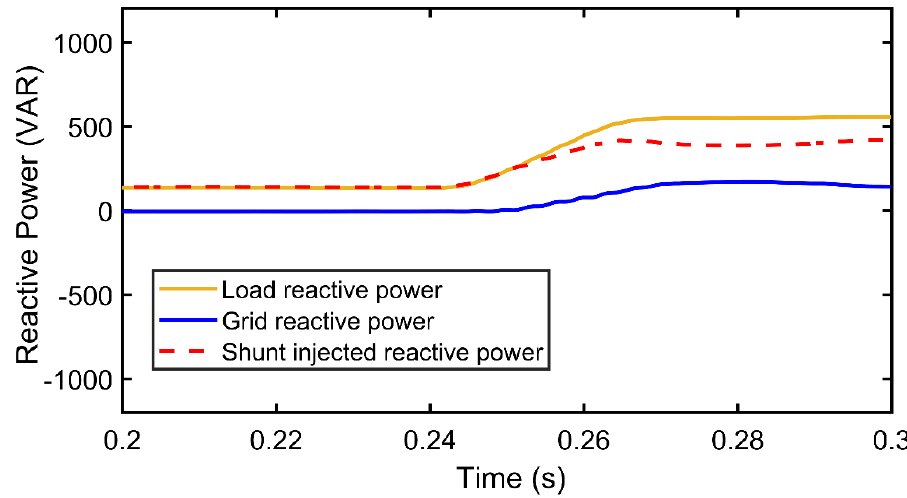
Figure 8. Reactive power management between grid load and PV under varying load demand.